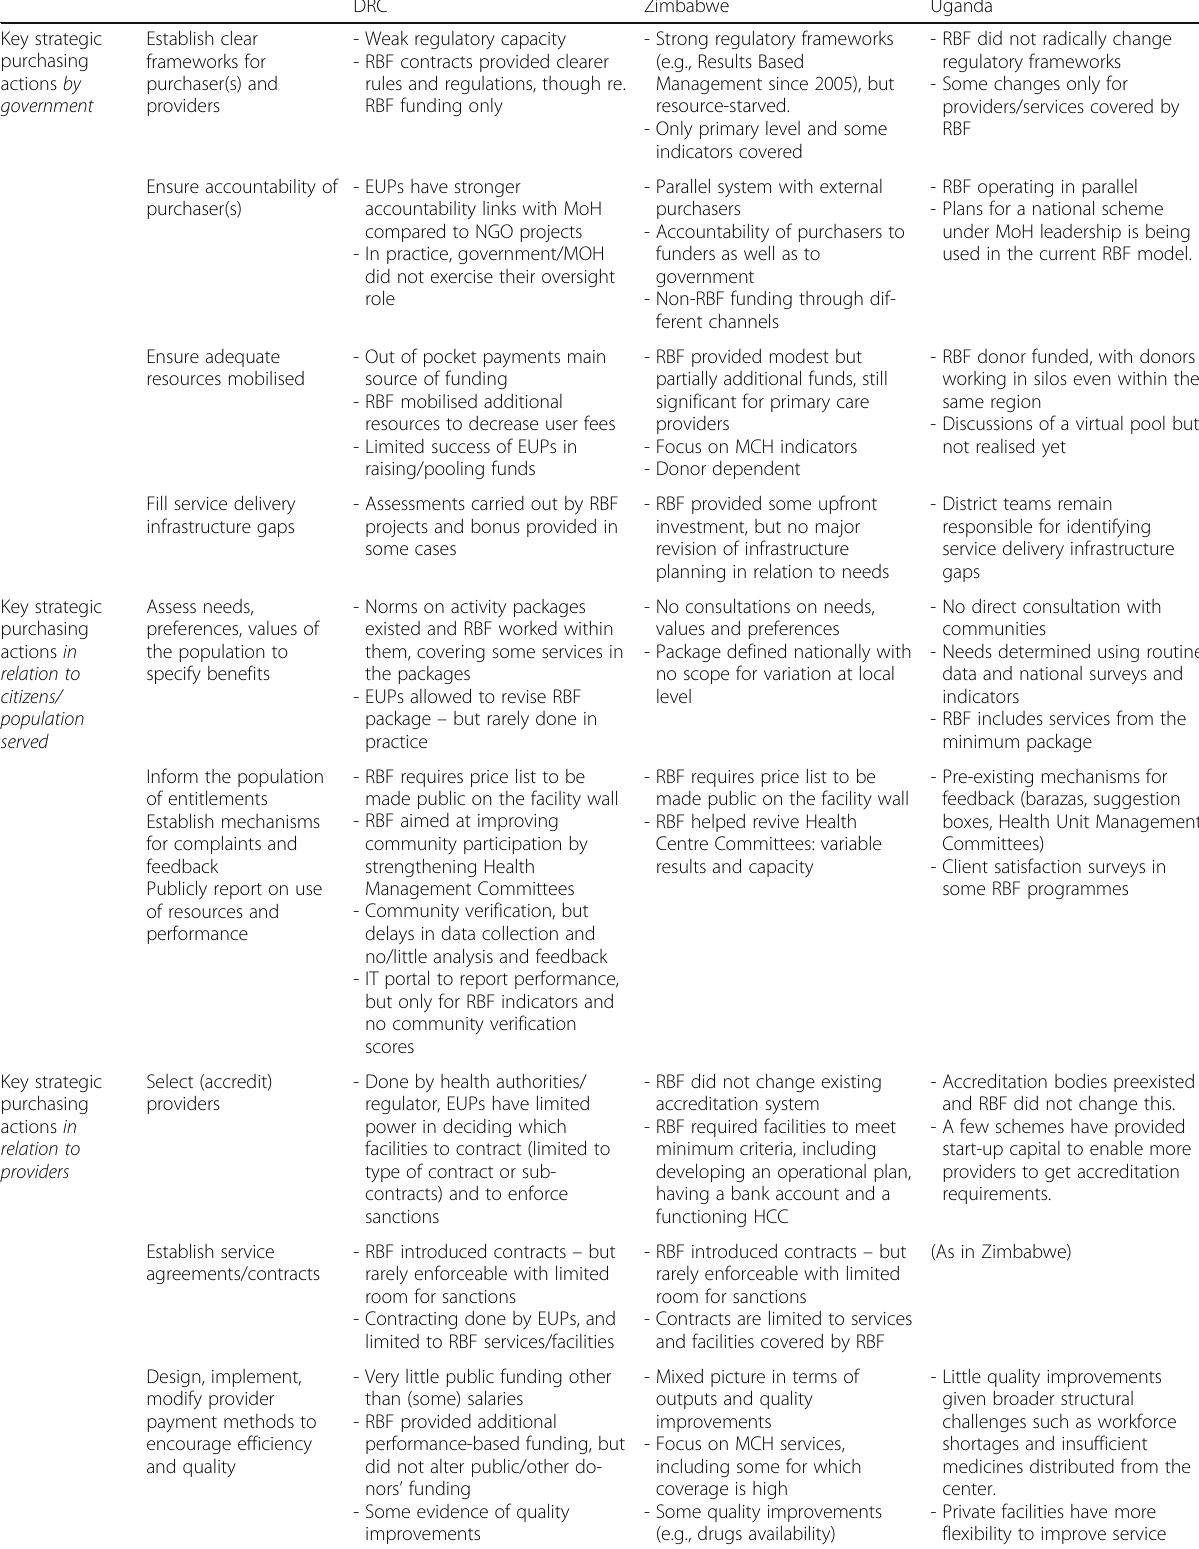
Table 3 Summary of key findings